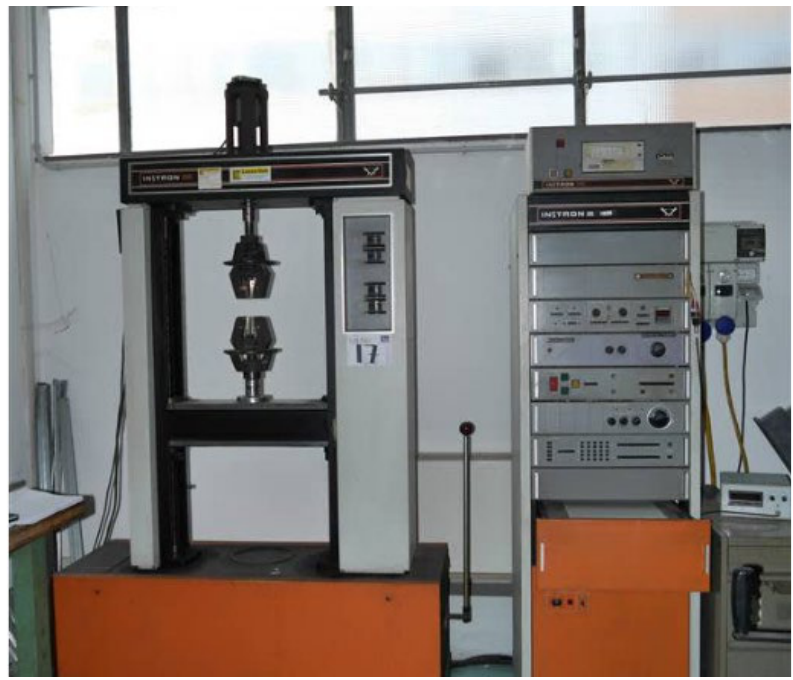
Figure 3. Buckling test machine.